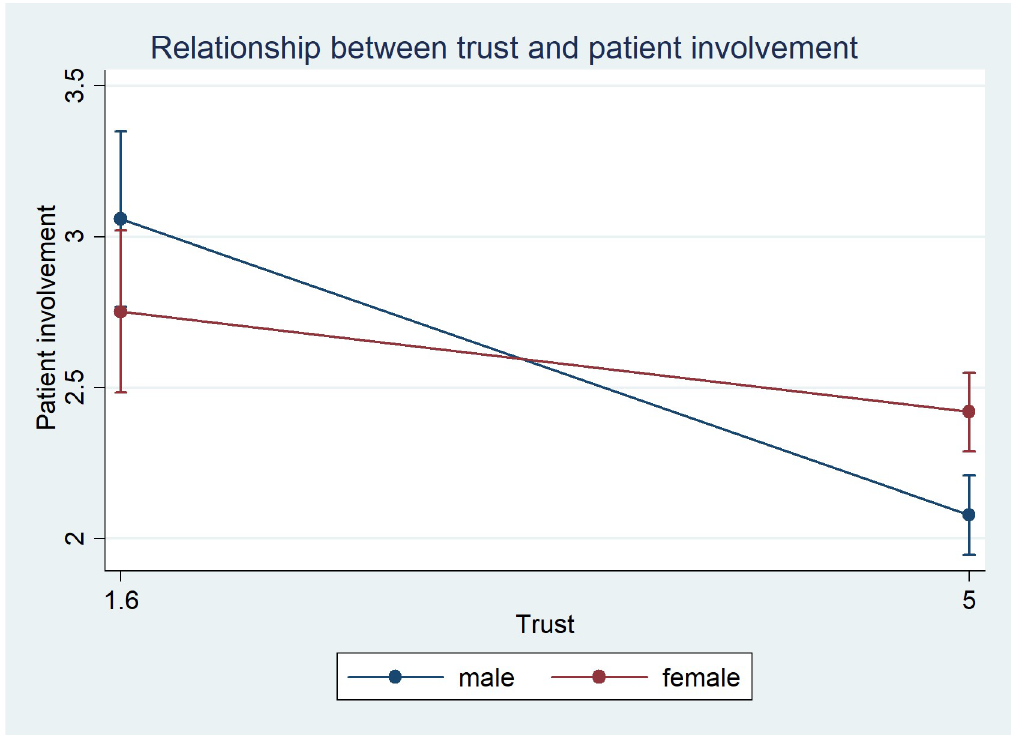
Fig 1. Relationship between trust and involvement in medical decision-making in men and